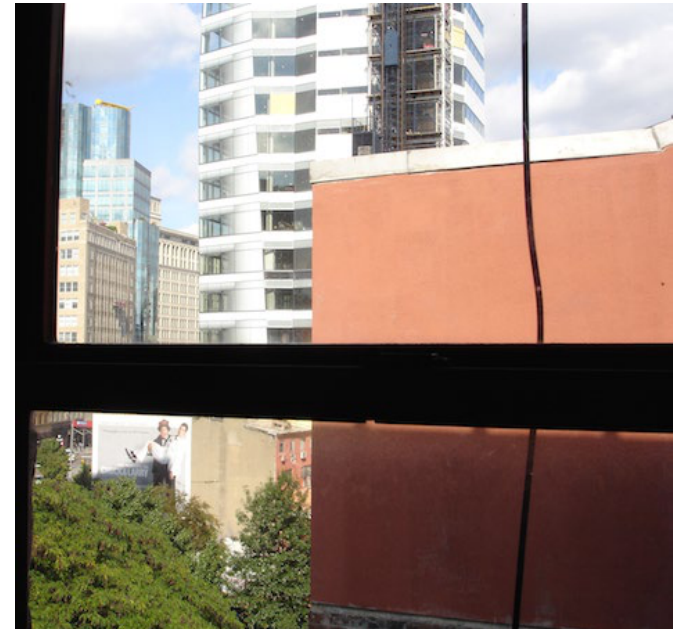
Figure 2. The Cooper Square neighbourhood under gentrification pressures: view from inside a CLT